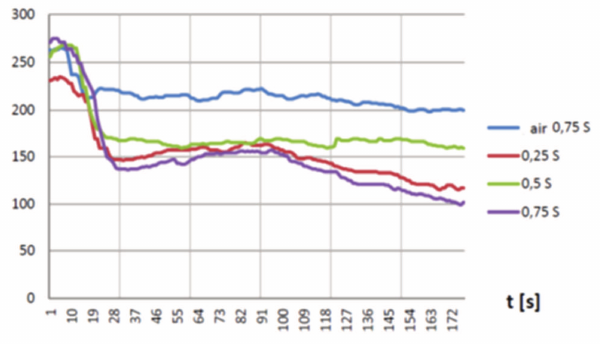
Fig. 7. Changes in concentrations of nitric oxides with a sorbent supply, where: 0,25S; 0,5S; 0,75S – degree of opening of the control valve; air 0.75S – air supply to the reactor at an opening of 0.75 valve